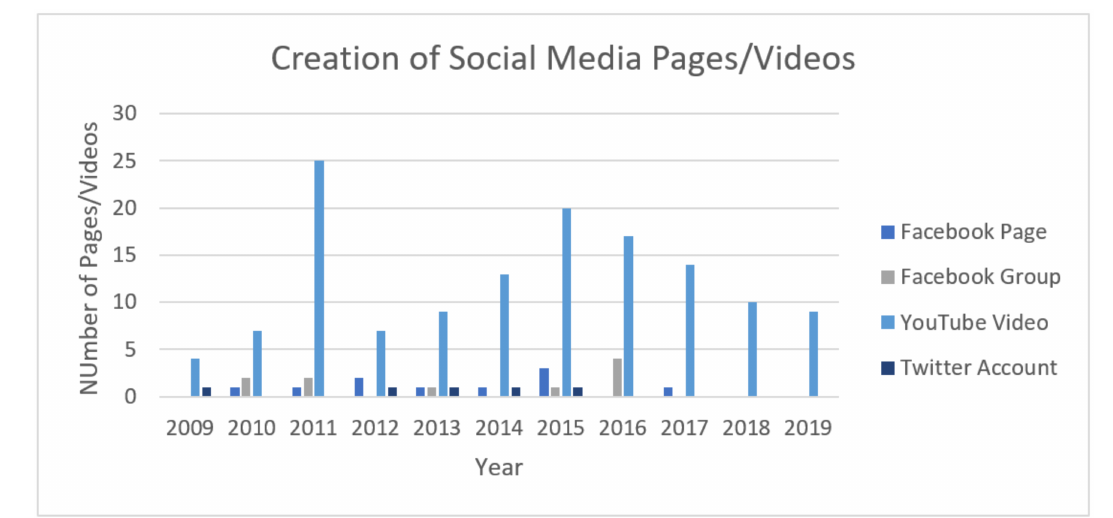
Figure 1. Social media platform accounts created by